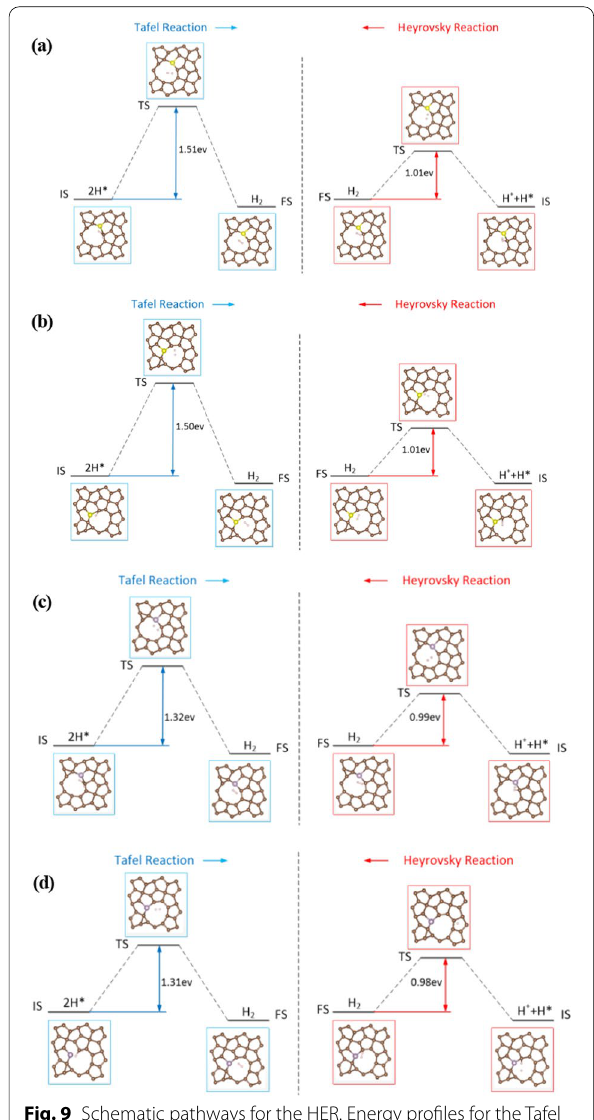
Fig. 9 Schematic pathways for the HER. Energy profiles for the Tafel and Heyrovsky reactions with a C 2-UP vacancy and S-doped PG, b C 2-DOWN vacancy and S-doped PG, c C 2-UP vacancy and P-doped PG, d C 2-DOWN vacancy and P-doped PG. The initial state (IS), the transition state (TS) and the final state (FS) are indicated in the diagram with the corresponding energy